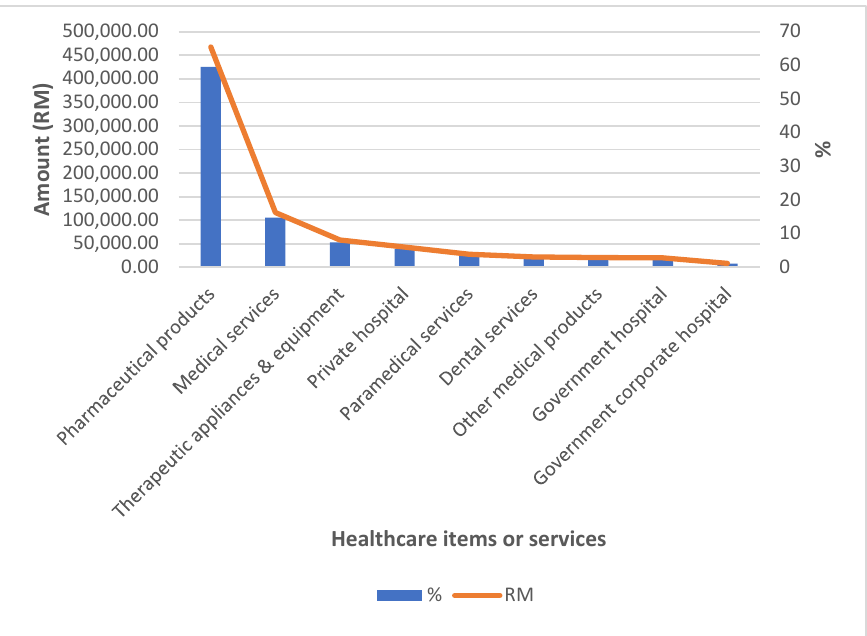
Figure 2. Distribution of monthly household OOP payments for healthcare services or items in HES, Malaysia 2014/2015 ( n = 14,473).